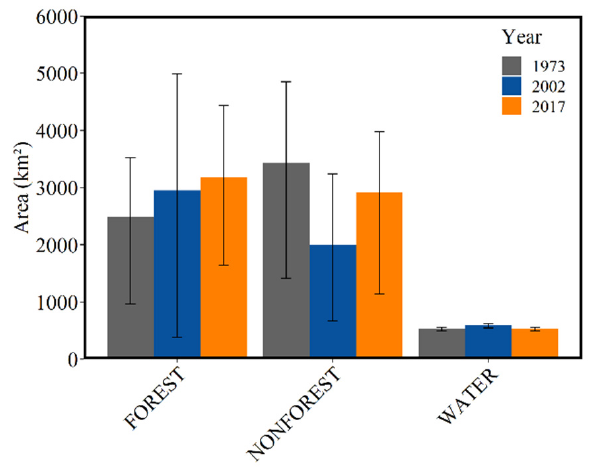
Figure 3. Conservative estimate ( > 50% probability) of extent of forest and non-forest. Upper error bars capture area with > 25% probability. Lower bars capture area with > 75% probability. Table 5. Estimated area for each land-cover type based on model classification with 50% or greater